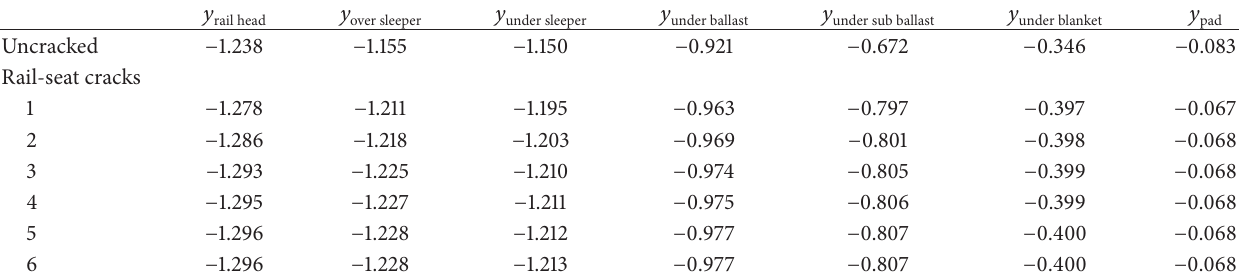
Table 8: Deflections (mm) in the track model with 1 to 6 rail-seat cracks.